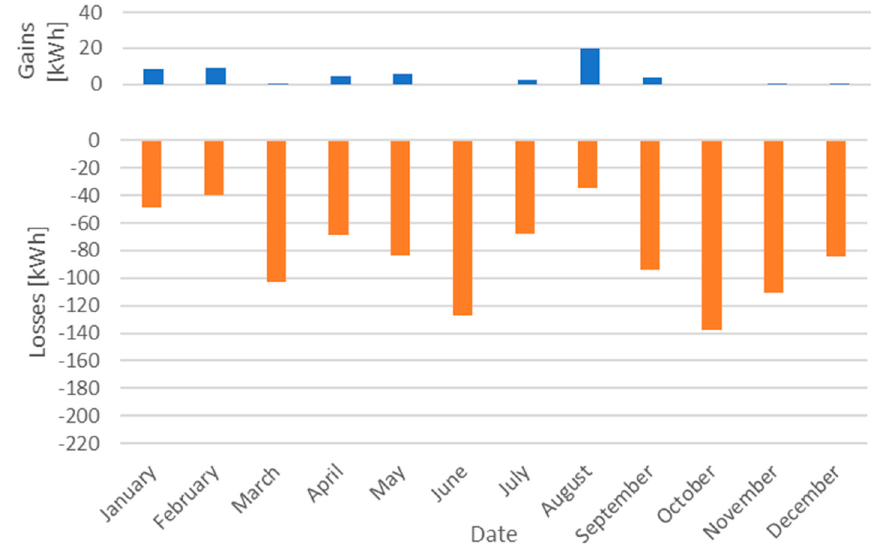
Figure 15. Monthly sum of energy flow between the floor and the ground in variant 3 (wooden floor, central heating).